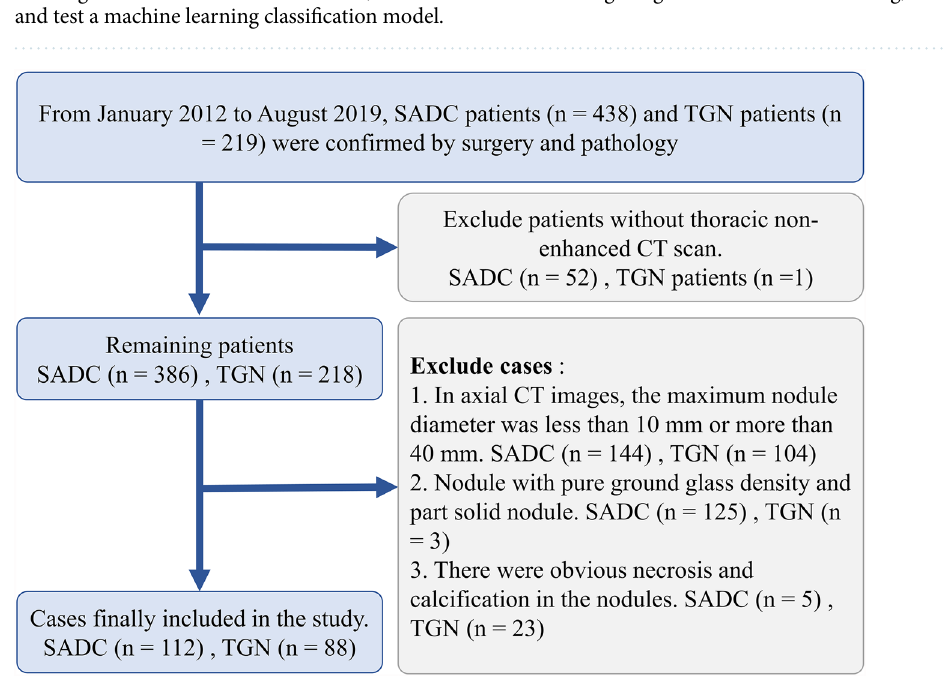
Figure 4. Flow chart of selecting case samples. Case elimination flowchart. 200 patients were selected according to the inclusion